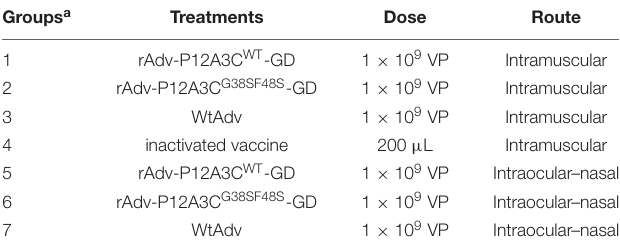
TABLE 2 | Vaccination strategy in the guinea pig experiment.